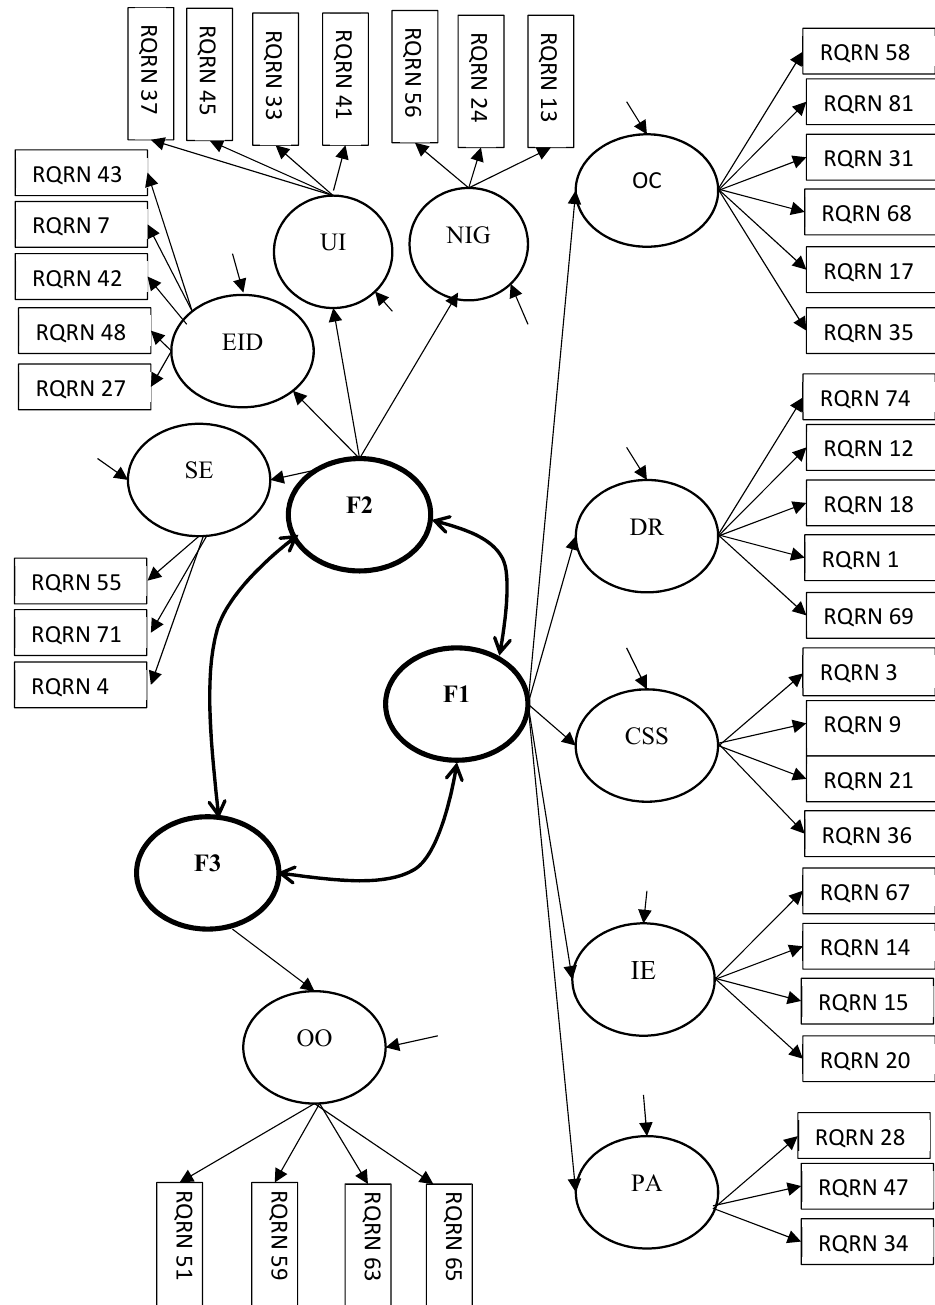
Figure 1. The Hypothesized Three Factor, Second Order Confirmatory Factor Analysis Model of the YPI-R3. OC = over-control; EID = emotional inhibition and deprivation; UI = undependability and irresponsibility; OO = overprotection and overindulgence; NIG = neglect and insufficient guidance; CSS = competitiveness and status seeking; IE = intrusiveness and exploitation; DR = degradation and rejection; SE = social exclusion; PA = punitiveness and abuse. F1 = authoritarian and/or abusive (second order of YPI-R3); F2 = neglectful and/or undependable (second order of YPI-R3); F3 = overprotective and overindulgent (second order of YPI-R3). RQRN = Item identification letters uniquely used in this